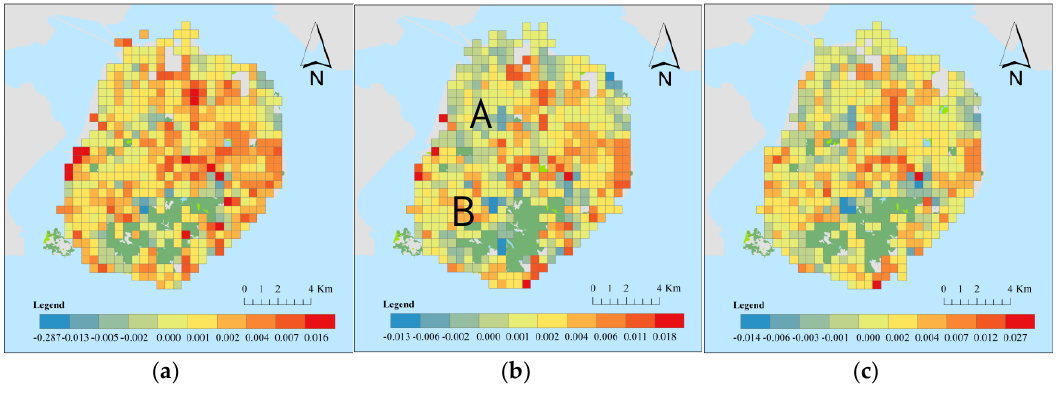
Figure 11. Spatial and temporal distribution of the average coefficient for the “road length” variable at three peaks. ( a ) Moring peak; ( b ) afternoon peak; and ( c ) evening peak. Region A represents high density of road; Region B represents railway station.